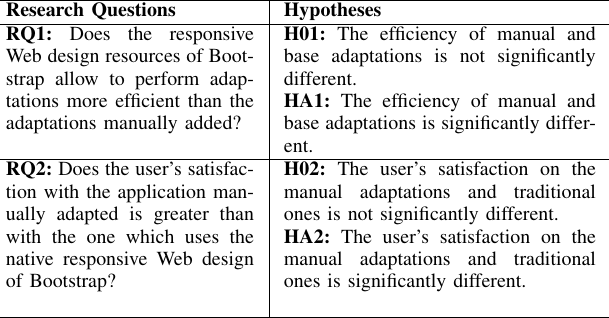
TABLE II R ESEARCH QUESTIONS AND